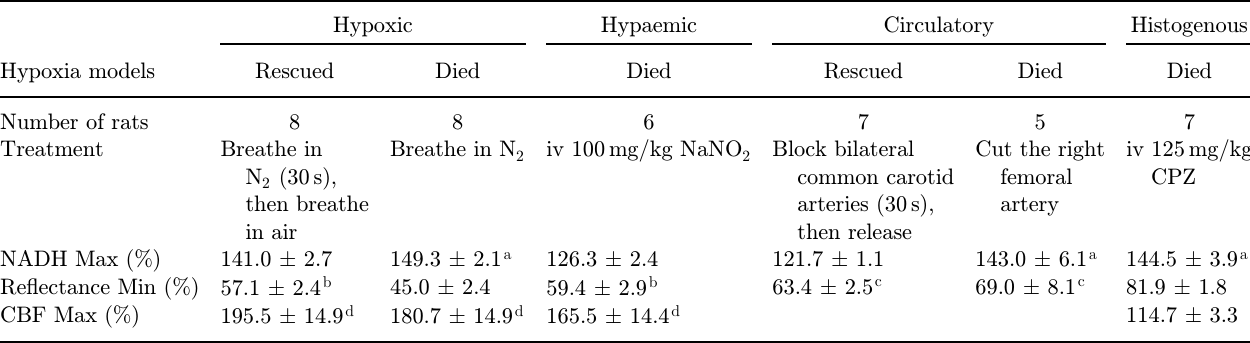
Table 1. Summary of treatments and results of the six acute hypoxia